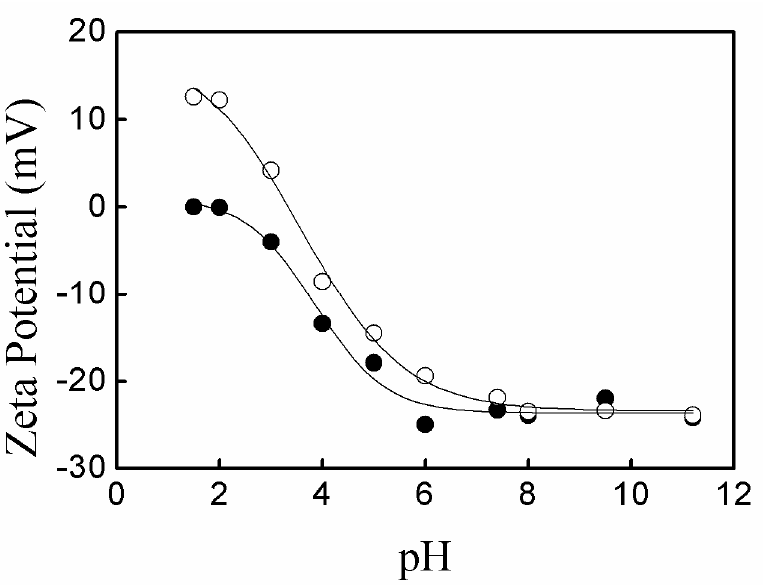
Figure 3. Variation of the zeta potential of P(AA- co -NVF) (solid) and P(AA- co -VAm) (hollow) microgel as a function of pH.